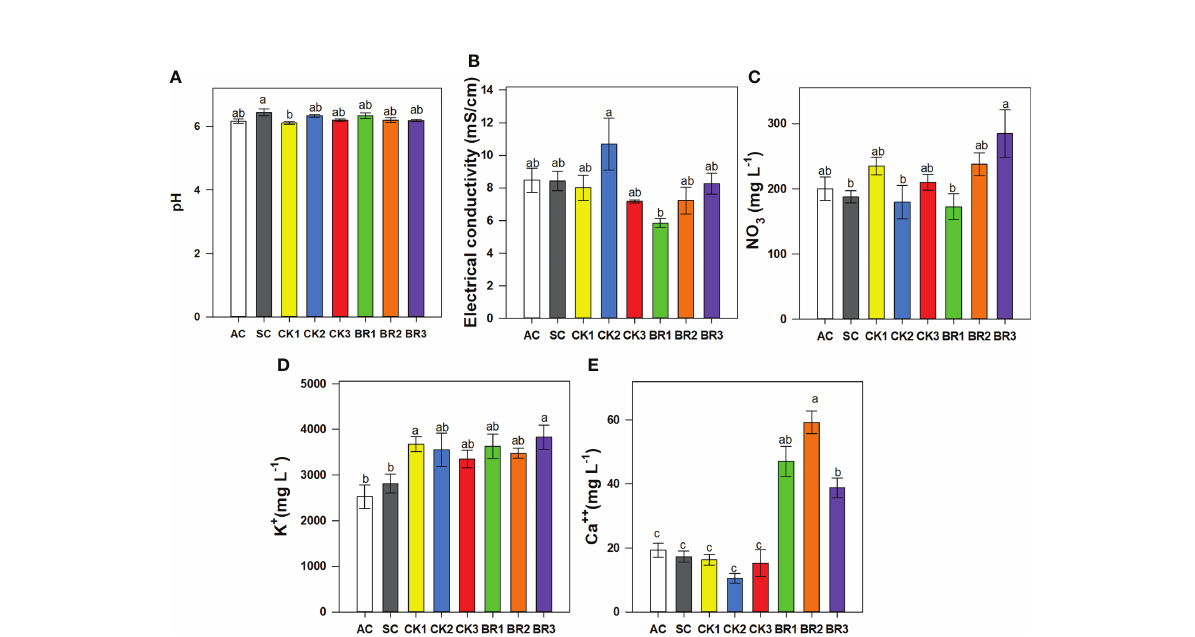
FIGURE 6 Effect of the number of applications of two growth regulators (cytokinins (CK) or brassinosteroids (BR)) on the pH (A) , electrical conductivity (B) , contents of nitrate (C) , potassium (D) , and calcium (E) in rice plants of genotype F2000 subjected to combined heat stress (40°C day/30°C night) at 88 days after emergence (DAE). The treatments evaluated were as follows: absolute control (AC), heat stress control (SC), one foliar spray of CK (CK1), two foliar sprays of CK (CK2), three foliar sprays of CK (CK3), one foliar spray of BR (BR1), two foliar sprays of BR (BR2) and three foliar sprays of BR (BR3). Each column represents the mean of fi ve data ± standard error (n = 5). Bars followed by different letters indicate statistically signi fi cant differences according to Tukey ’ s test (P ≤ 0.05). Equal letters indicate that the means are not statistically signi fi cant ( ≤